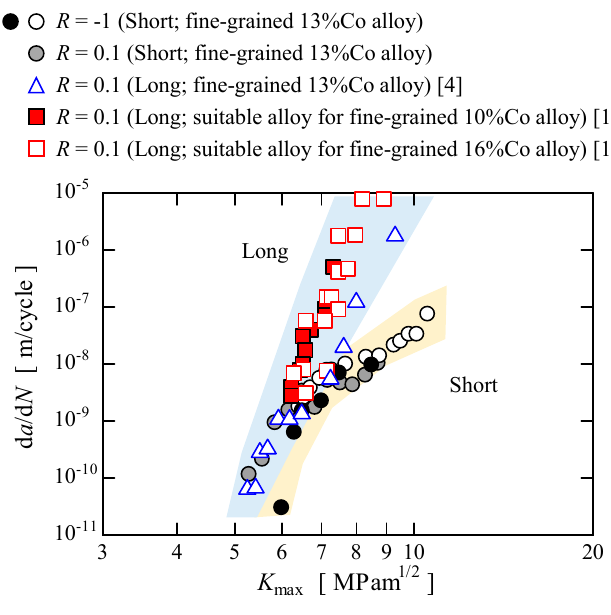
Figure 13. FCG rate for several fine grained alloys as a function of K max values.